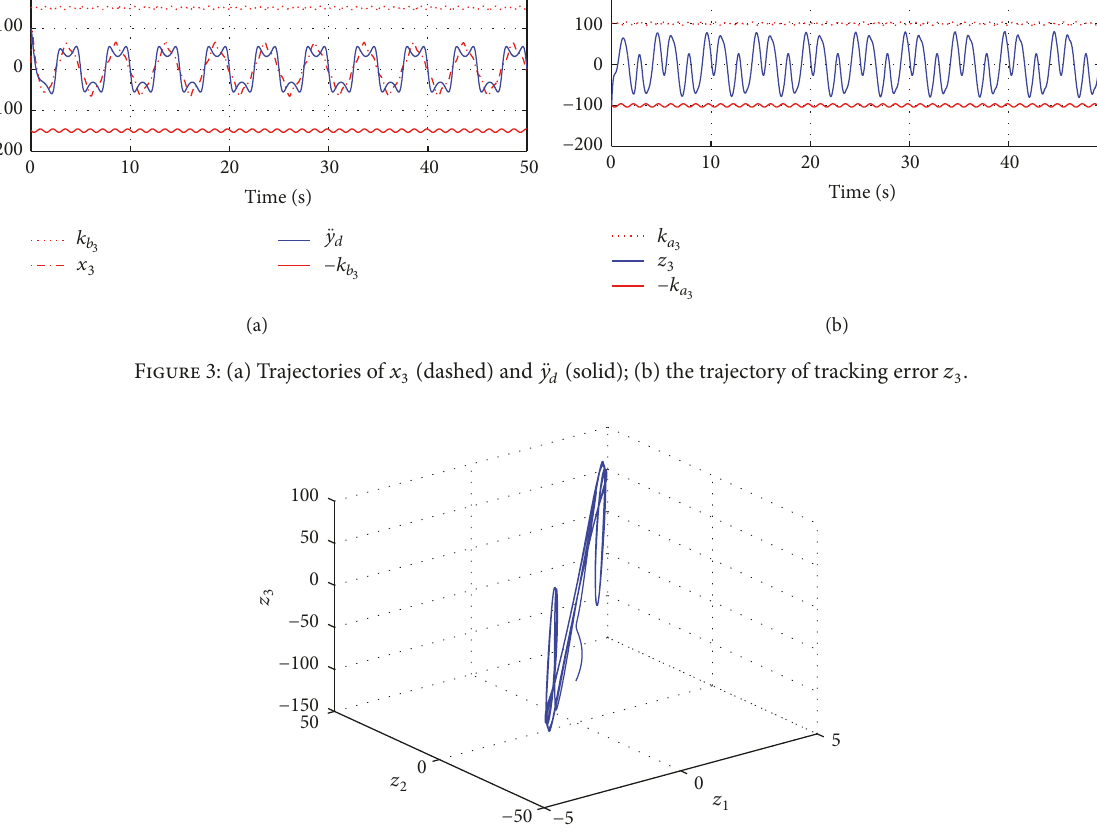
̂𝑊 2 ; (c) the trajectory of